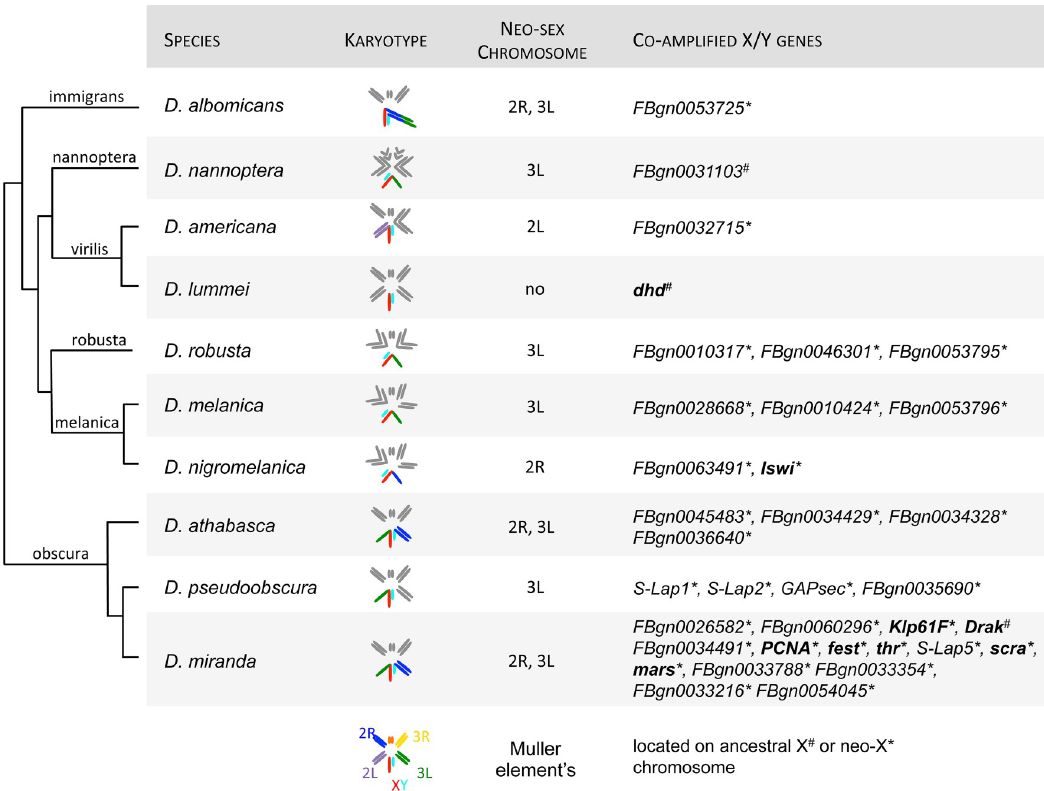
Fig 1. Co-amplified X and Y-linked genes across Drosophila species. Shown is the karyotype for each species with co-amplified X and Y genes, which chromosome arms form the neo-sex chromosomes (based on synteny in D . melanogaster ), and the name of co- amplified X and Y genes (based on their orthologs in D . melanogaster ). Genes in bold have functions related to chromosome segregation. Phylogenetic relationships are from ref. [69], and the species group is indicated above the